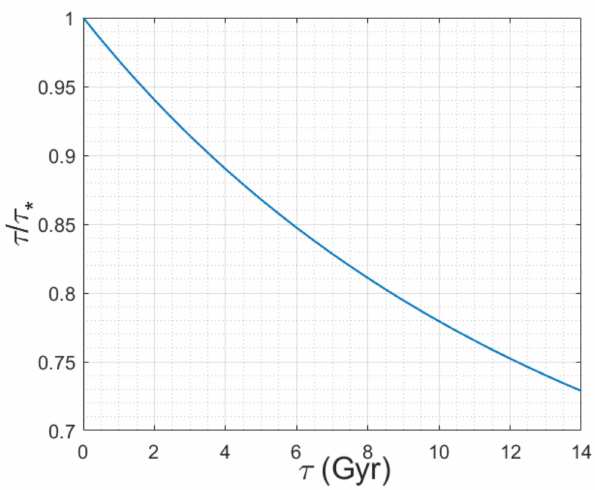
Figure 2. Variation of the ratio τ / τ ∗ with stellar main-sequence age for the CCC model value of . G 0 / G 0 = 390 × 10 − 12 yr − 1